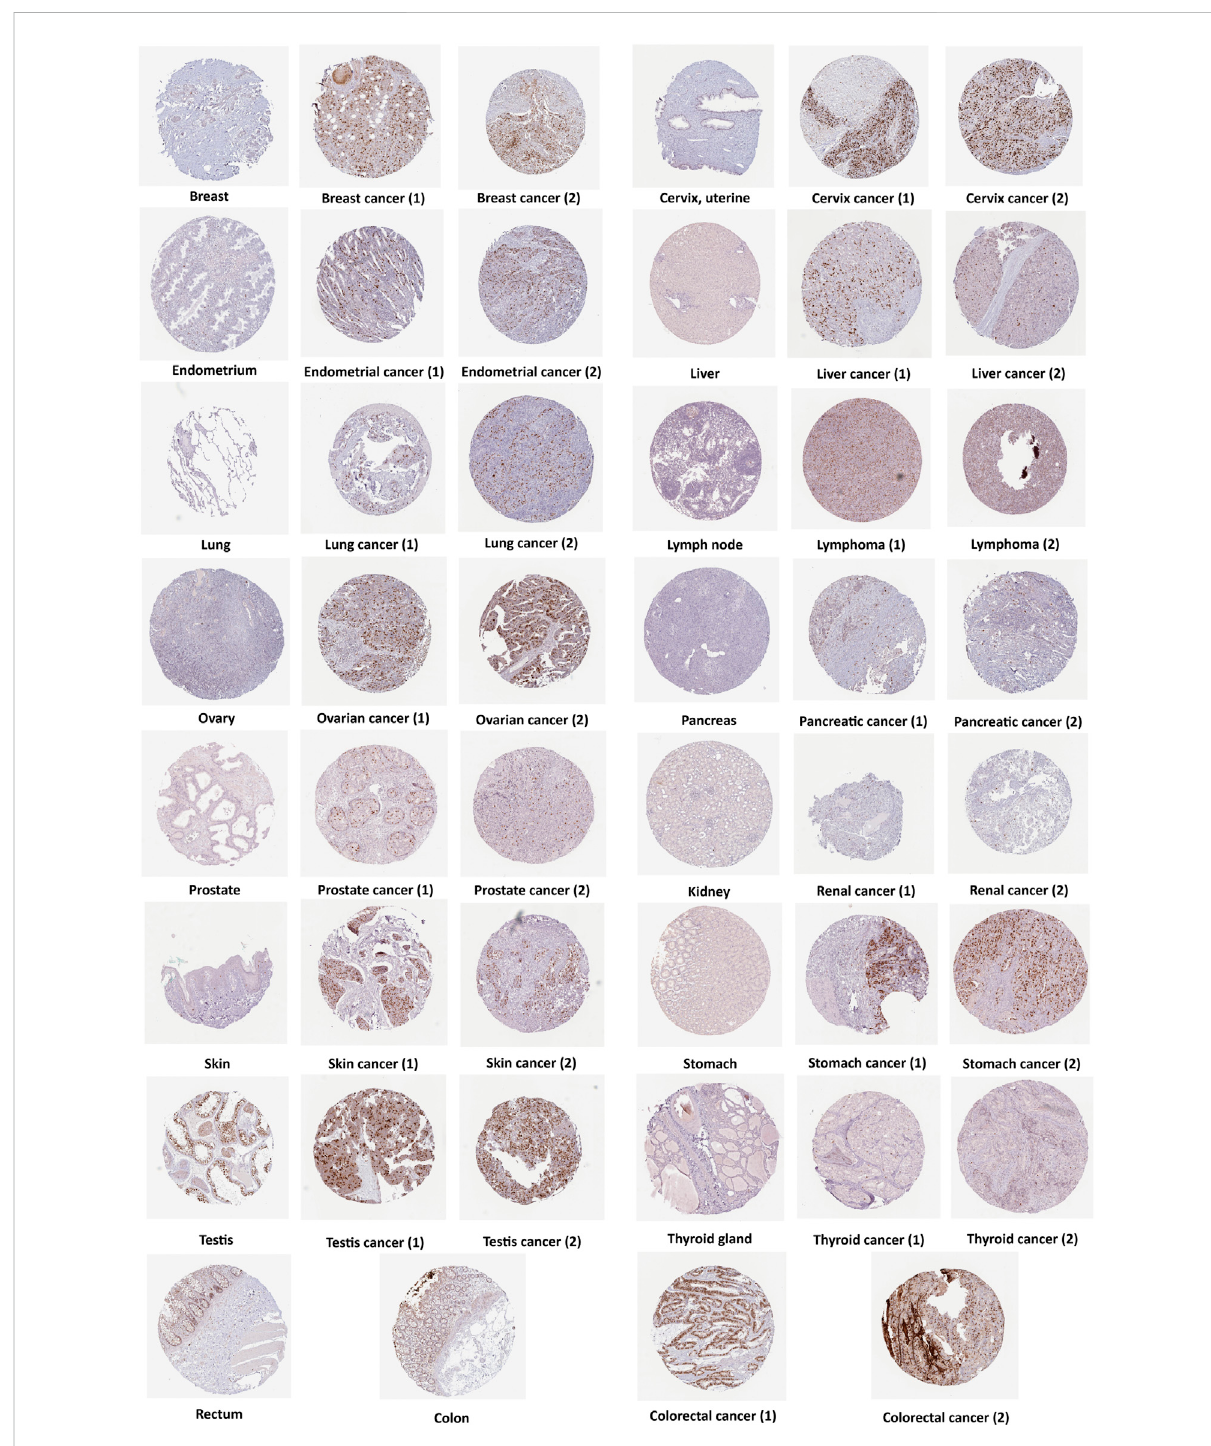
FIGURE 2 ANLN protein expression in immunohistochemical images of normal (left) and tumor (right)